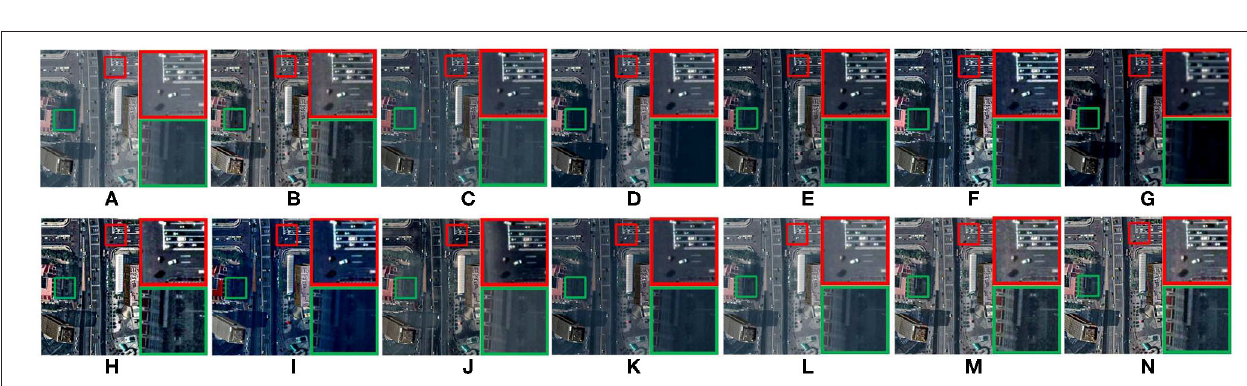
FIGURE 8 | Remote-sensing geographic image. (A) Represents the original foggy image. (B–N) Represent foggy-free images processed by AMEF, CAP, CO, DCP, DEFADE, GPR, MAMF, OTE, WCD, DehazeNet, FFA-Net, MIF, and the proposed method.